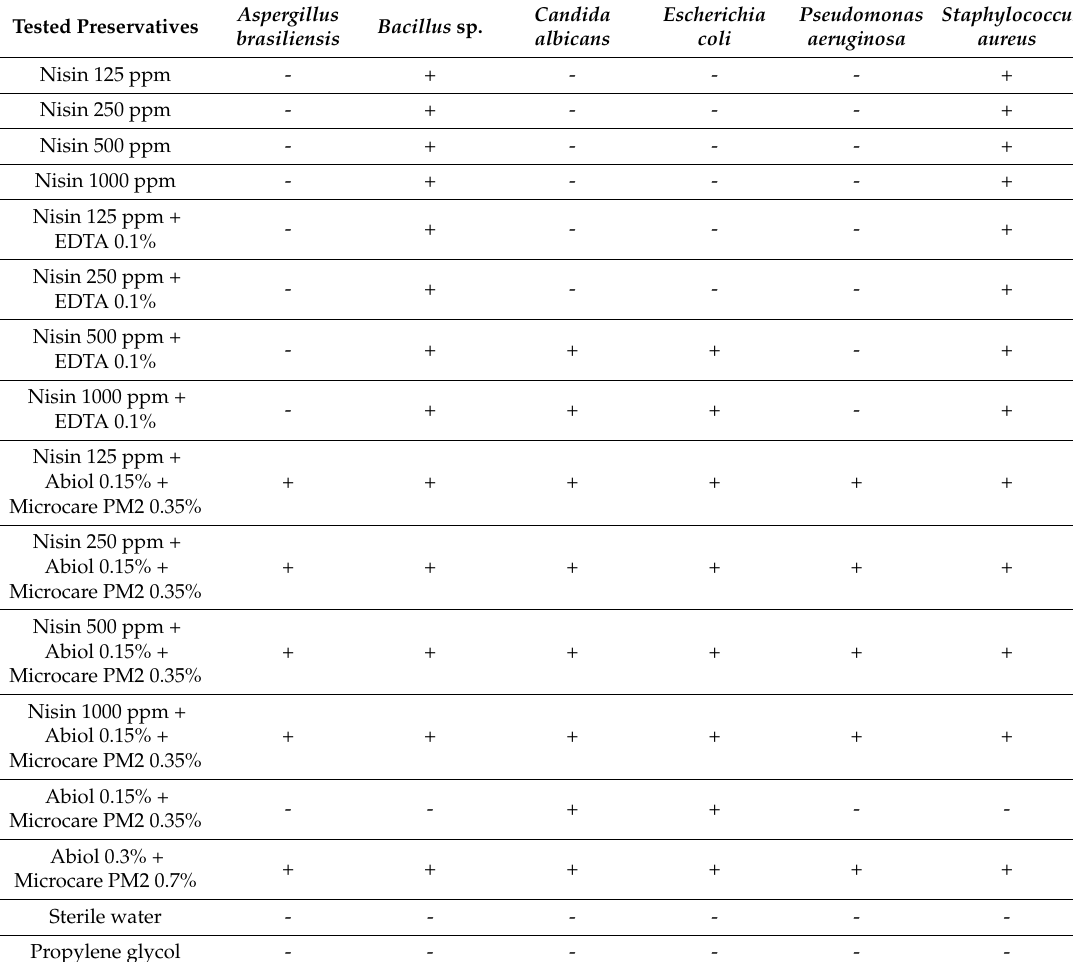
Table 2. Results of disk diffusion assay for nisin and other preservatives. (+) inhibition zones—between 10 and 20 mm; (-) inhibition zones <10 mm—inefficiency of antimicrobials tested. Aspergillus Bacillus brasiliensis